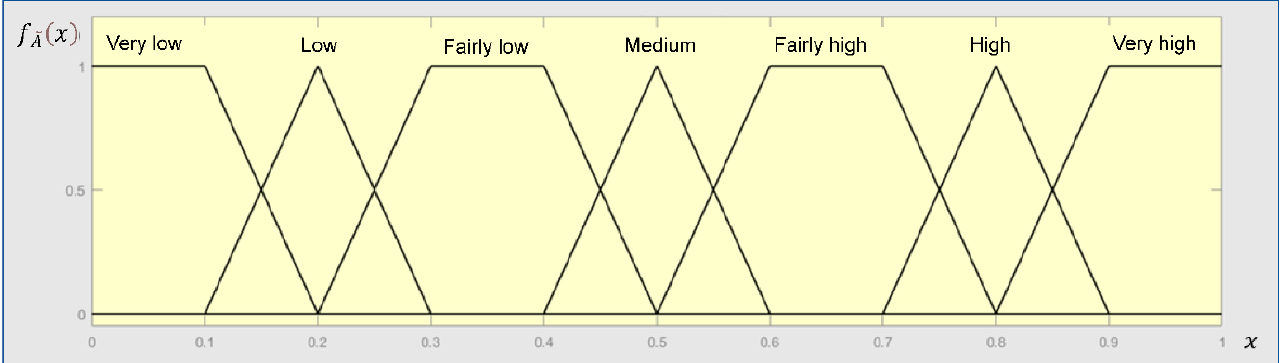
Figure 4. The conversion scale including seven qualitative terms.